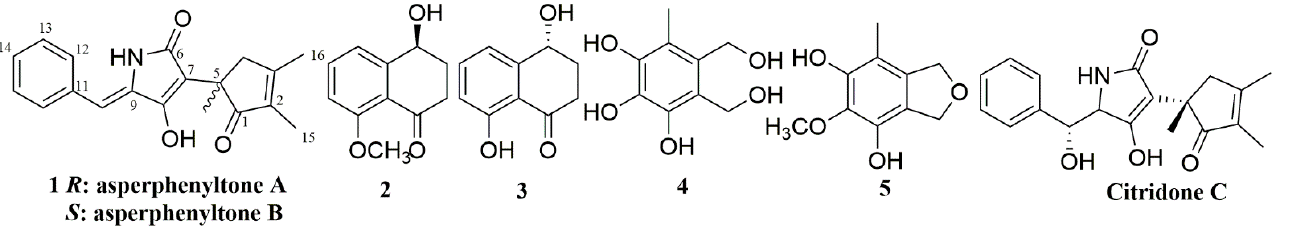
Figure 1. Structures of 1 – 5 .